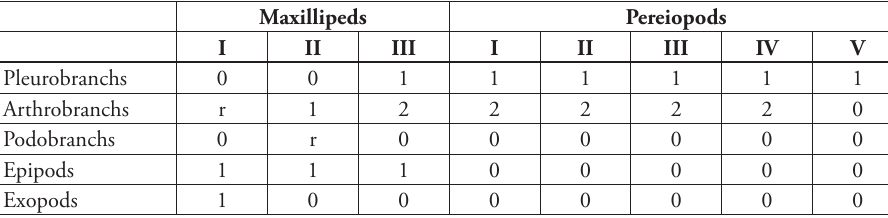
Table 1. Branchial formula of Spongicoloides weijiaensis sp. n. (r =